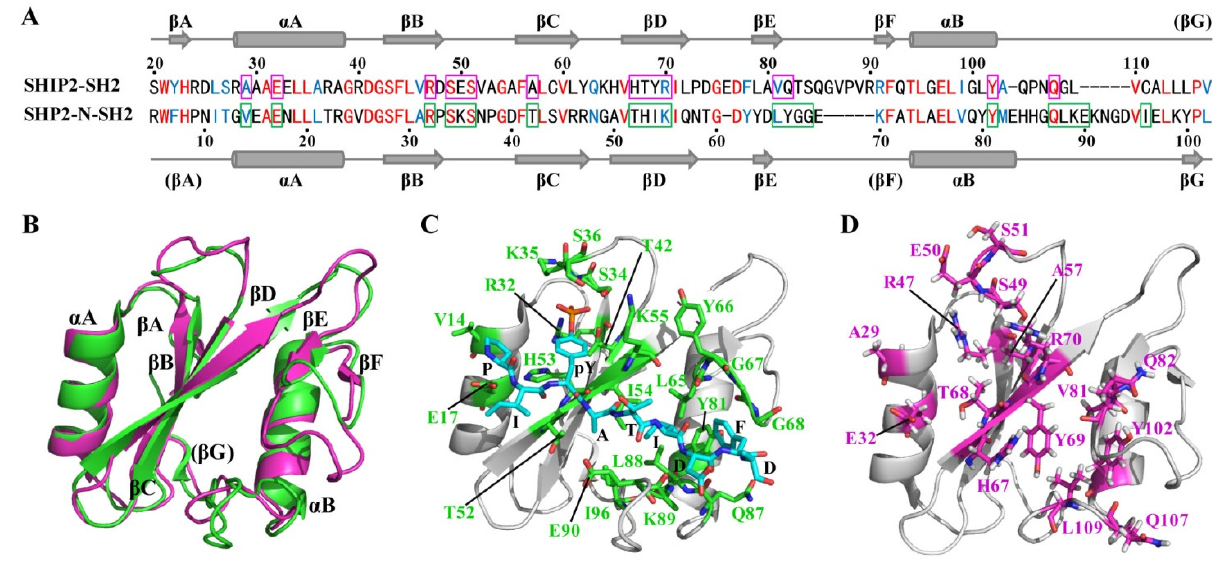
Figure 3. Comparison of the sequence and structure of SHIP2-SH2 and human SHP2 N-SH2. ( A ) Sequence alignment of SHIP2-SH2 and SHP2 N-SH2. The identical residues are colored in red, while similar residues are in blue. Secondary structural elements are marked on top and bottom, respectively, for SHIP2-SH2 and SHP2 N-SH2, and those in brackets show loop structure in corresponding structures. The SHP2 N-SH2 residues labeled by green boxes show contact with the CagA EPIYA-D phosphopeptide in the complex structure (PDB ID: 5X94), while the corresponding residues in SHIP2- SH2 are labeled by magenta boxes. ( B ) Superimposition of the structures of SHIP2-SH2 (magenta, PDB ID: 2MK2) and SHP2 N-SH2 (green, PDB ID: 5X94, chain A). ( C ) The complex structure of SHP2 N-SH2 binding with the CagA EPIYA-D phosphopeptide (PDB ID: 5X94). The SHP2 N-SH2 residues in contact with CagA EPIYA-D phosphopeptide are shown in sticks and colored in green, while the residues belonging to EPIYA-D are shown by cyan sticks. ( D ) The structure of apo SHIP2- SH2 with the residues corresponding to the EPIYA-D-interacting SHP2 N-SH2 residues shown by magenta